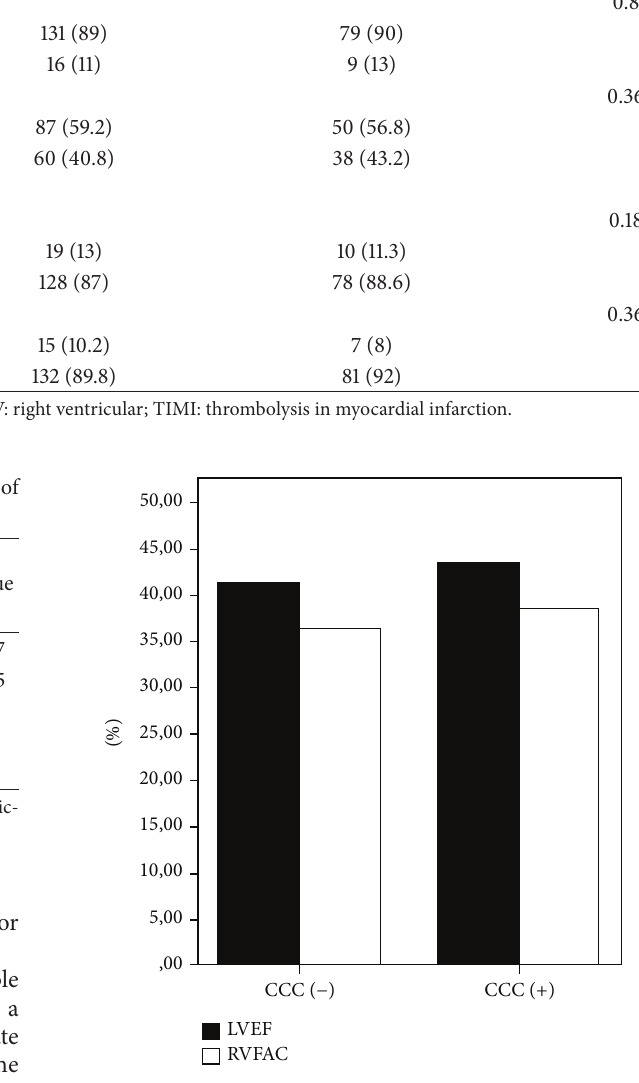
Figure 1: The difference of the groups in respect to left ventricular ejection fraction (LVEF) and rightventricular fractional area change